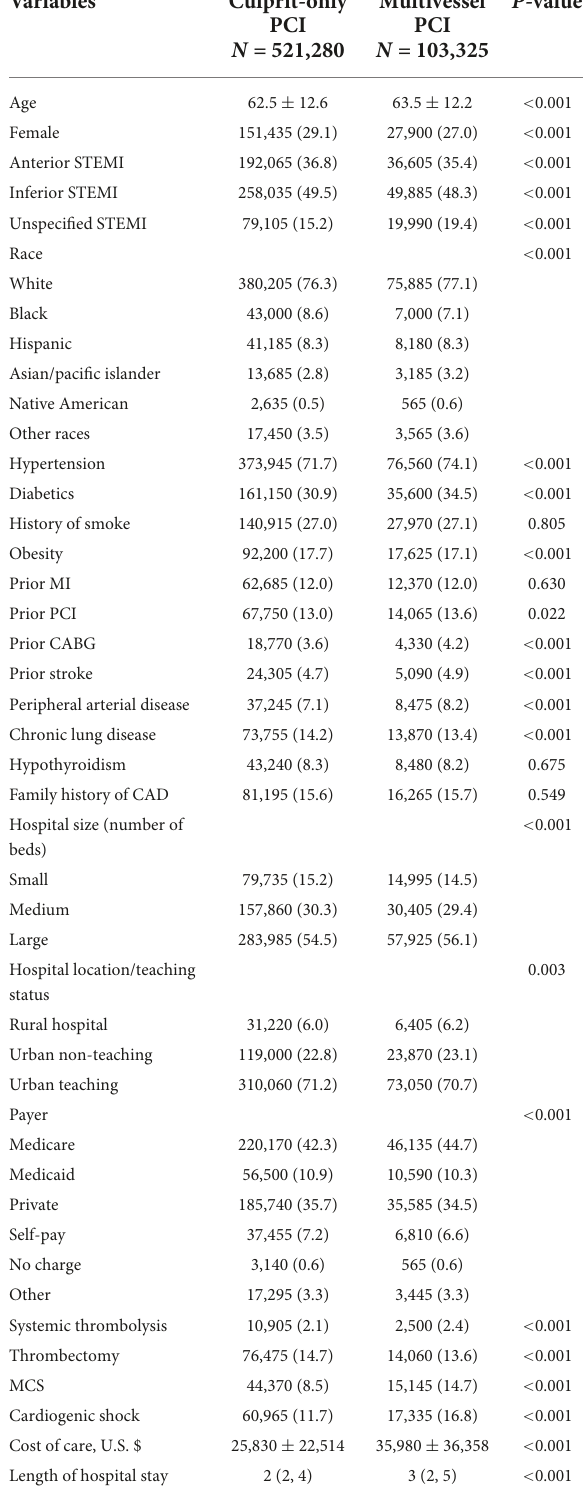
( Figure 2 ). The rate of in-hospital mortality was comparable between the two groups in each calendar year during the study period ( Supplementary Figures 2, 3 ). Logistic